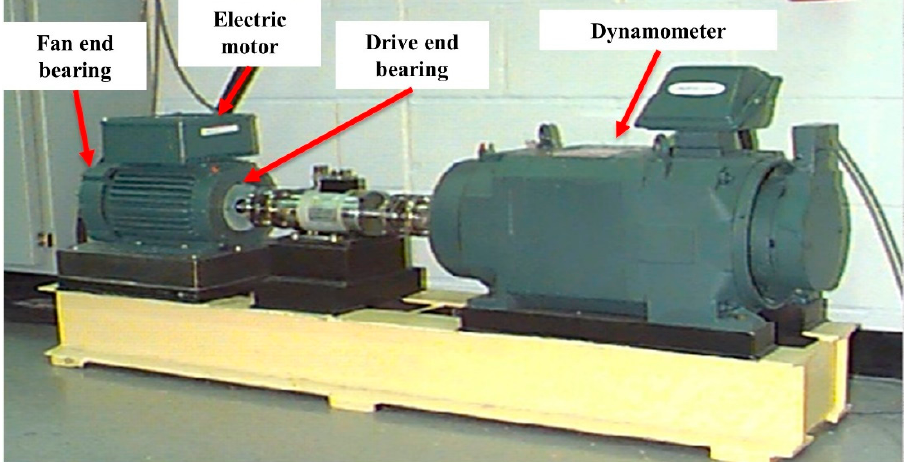
Figure 10. Measuring position of each vibration signal in the CWRU dataset.